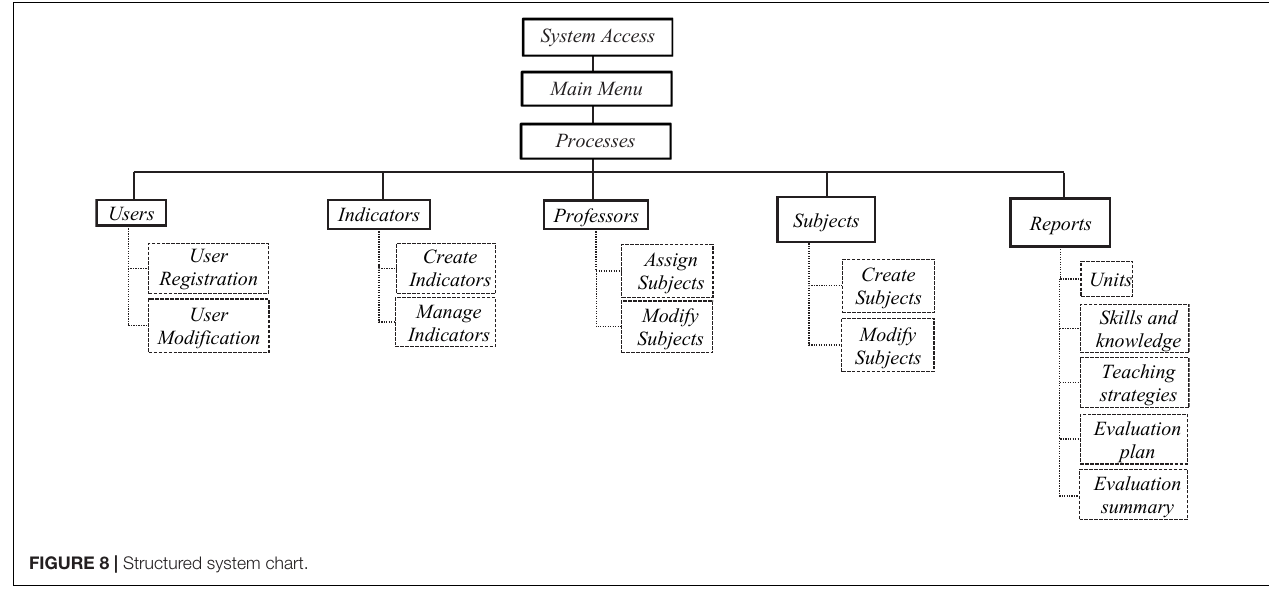
Table: conceptual_dimension Columns: